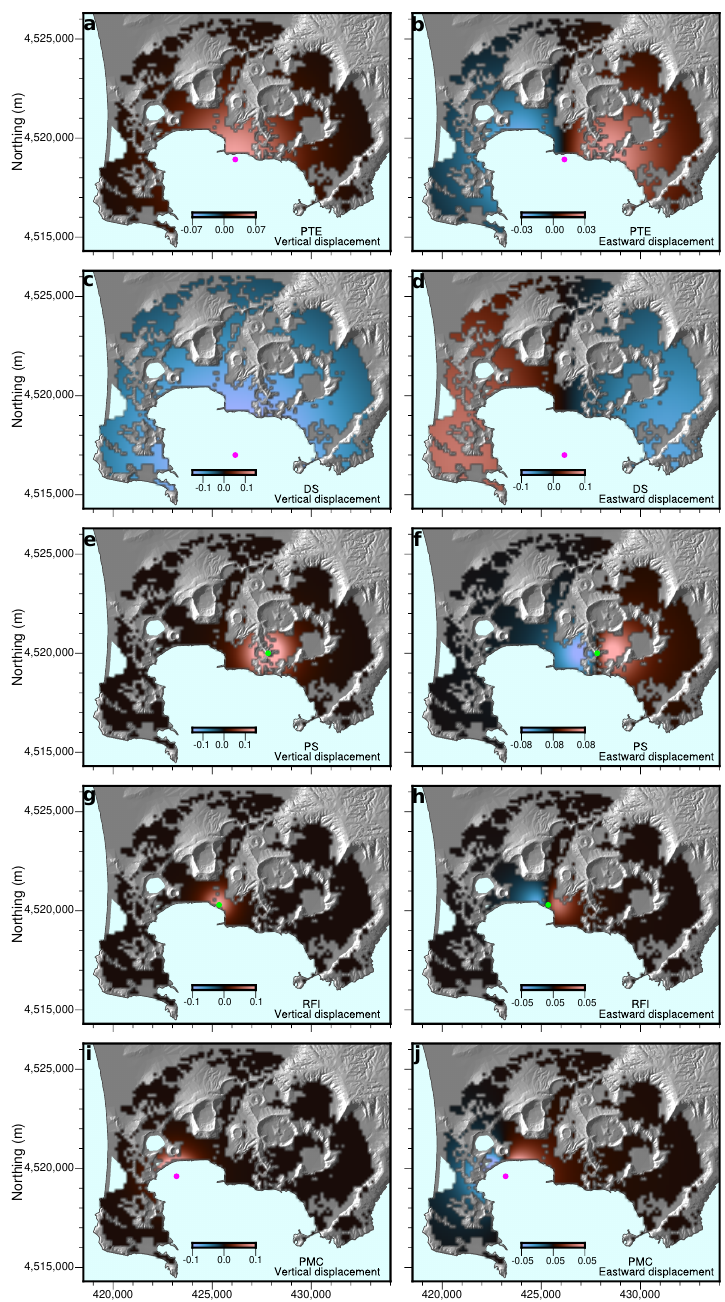
Figure 9. Contribution of each deformation source to the differences between the 1993–2000 and 2015–2022 normalized EOFs. Maps show Equation (3), where subscript k indicates the deformation source. ( a ), PTE, vertical displacement; ( b ), PTE, eastward displacement; ( c ), DS, vertical displacement; ( d ), DS, eastward displacement; ( e ), PS, vertical displacement; ( f ), PS, eastward displacement; ( g ), RFI, vertical displacement; ( h ), RFI, eastward displacement; ( i ), PMC, vertical displacement; ( j ), PMC, eastward displacement. The green or magenta dot in each panel gives the center position of the related